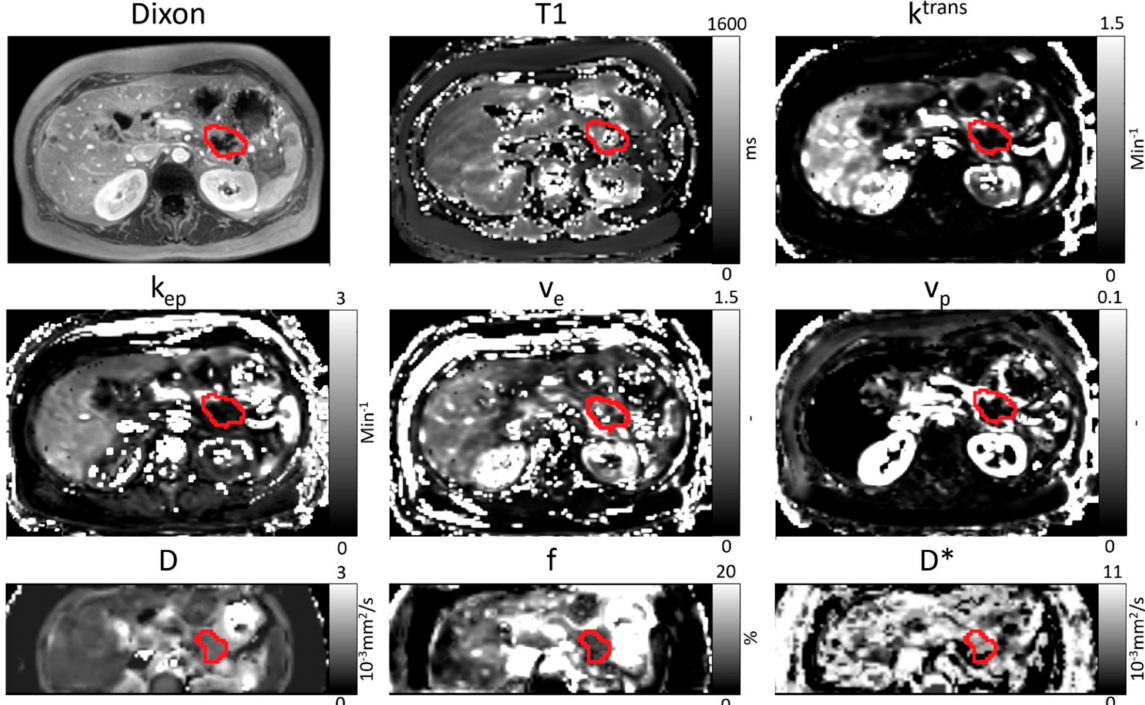
Figure 3. Example of an anatomical image (Dixon), T1 map, parameter maps of DCE MRI (ktrans, kep, ve, and vp), and parameter maps of IVIM-DWI MRI (D, f and D*) for one patient at baseline. The primary tumor is manually delineated in red. The delineation is performed separately for IVIM-DWI and DCE MRI